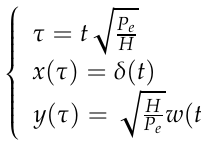
1 λ = − ). Figure 16. Identification of unknown parameters ˆ a and ˆ b (with disturbance, λ 1 = − 1